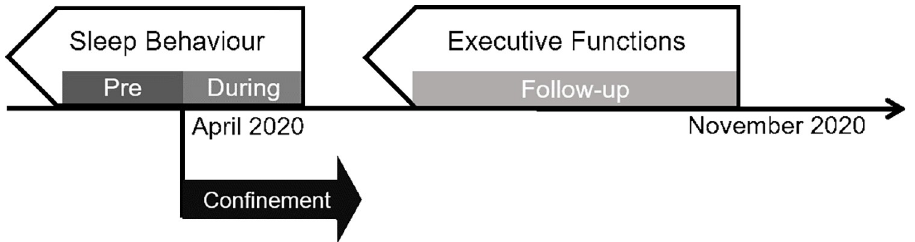
Fig 2. Overview of the study design. During April 2020, the first survey was completed to assess parent-reported sleep of young children during the confinement «during-CONFINEMENT» with the identical questions addressing the time before the confinement «pre-CONFINEMENT». In November 2020, a “FOLLOW-UP” was completed to assess executive functions with a questionnaire referring to children’s behavior retrospectively for the preceding 6